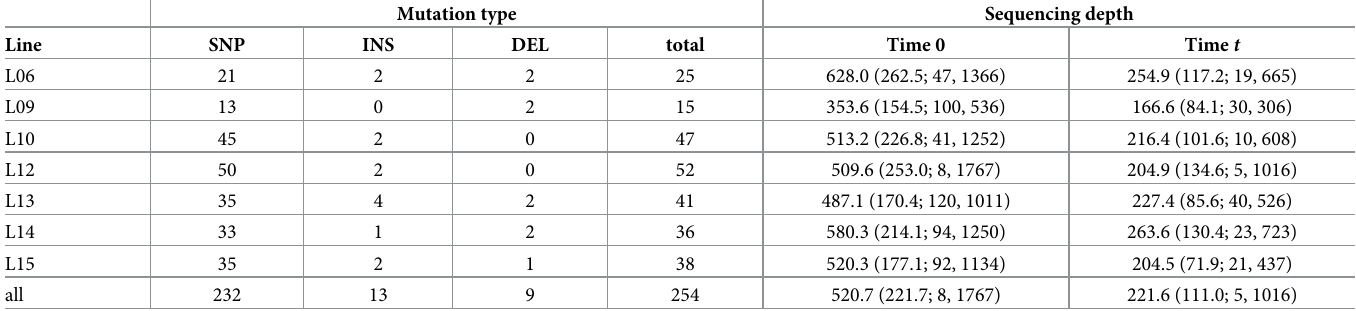
Table 2. Numbers of mutations in each MA line and sequencing depth statistics at the start and end of experimental evolution for the corresponding recombinant populations. Average sequencing depth across all mutations and replicates is shown along with the standard deviation and range in parenthesis.